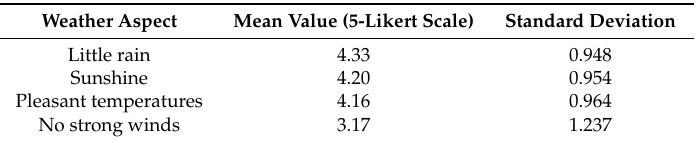
Table 3. Importance of weather aspects for a holiday in the Bavarian